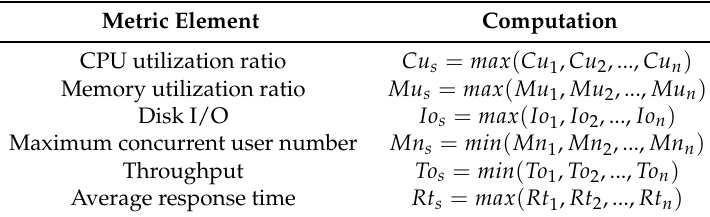
Figure 2. The parallel relation system. Table 4. The computation of the parallel relation